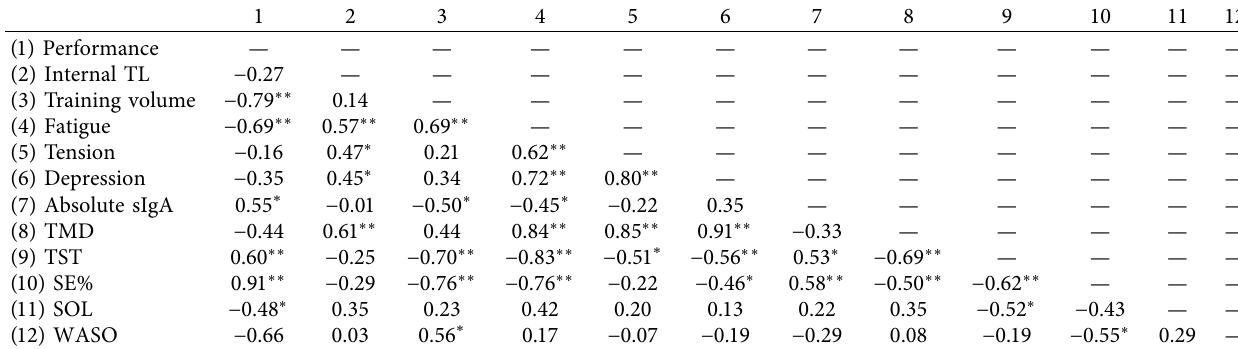
Table 5: Correlation calculated on pooled data for both adapted and maladapted athletes.